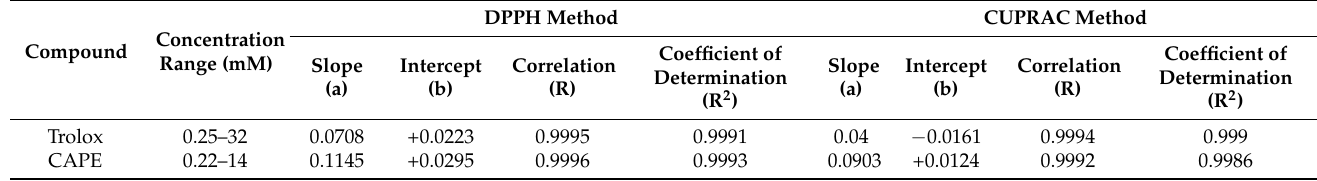
Table A2. Calibration curve (y = ax + b) data obtained by DPPH and CUPRAC assays for the tested compounds. Concentration Compound Range